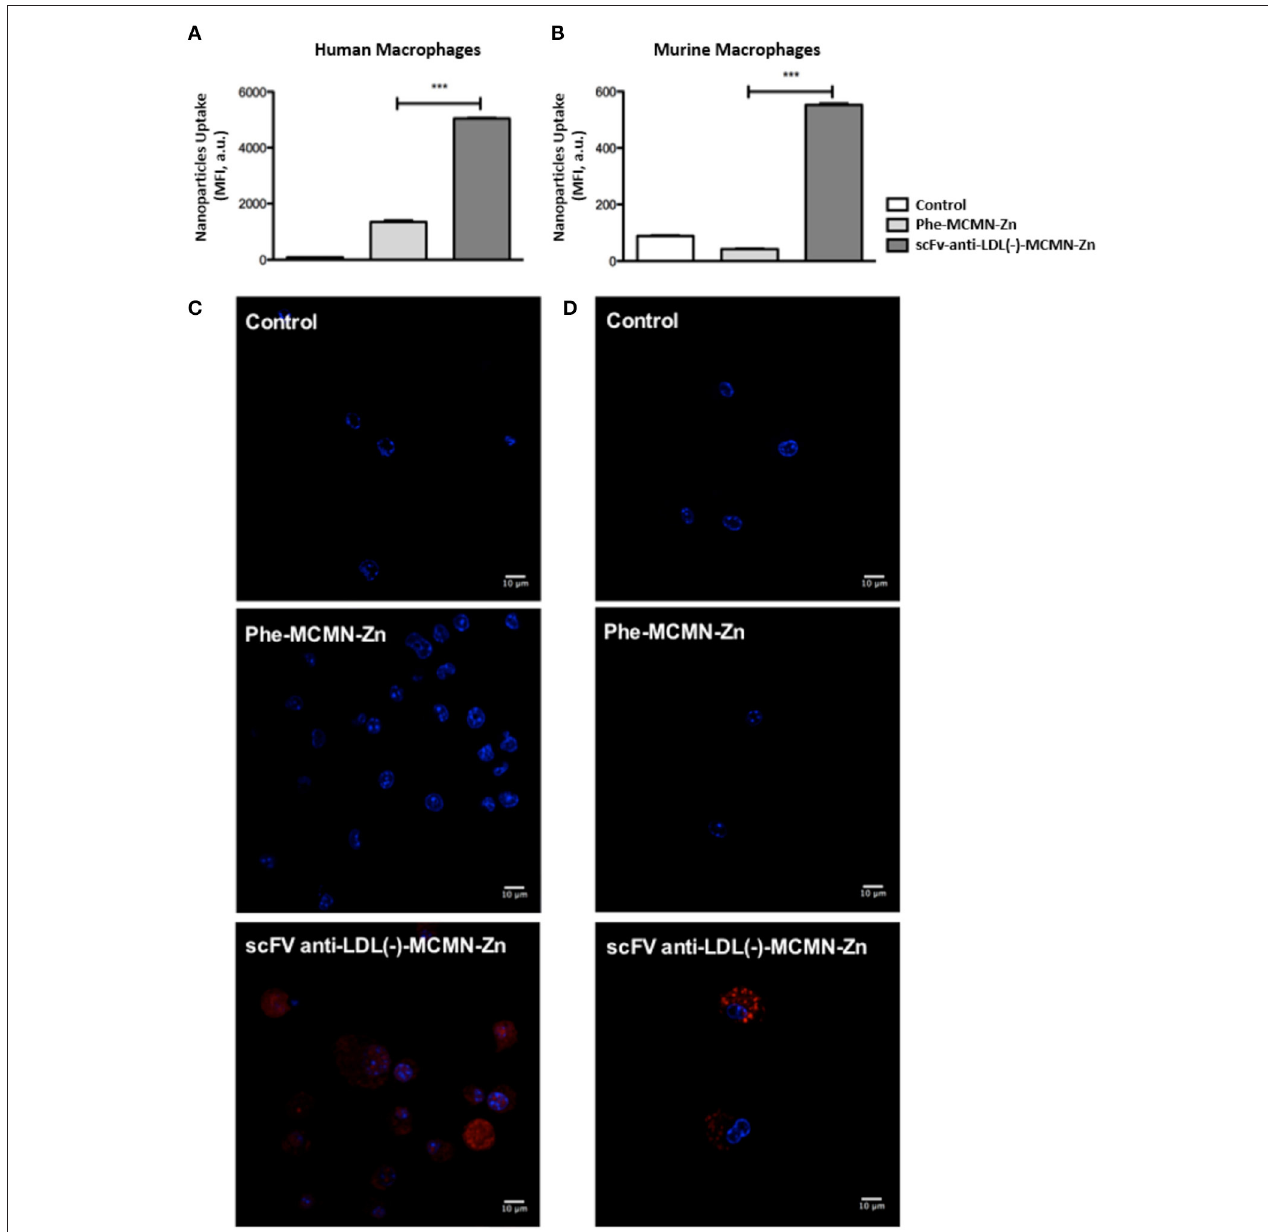
FIGURE 1 | Internalization of the scFv-anti-LDL(-)-MCMN-Zn nanoformulation by human and murine primary macrophages. (A,B) Flow cytometry measurements data from human (A) and murine (B) primary macrophages treated with 10 4 particles/mL of scFv-anti-LDL(-)-MCMN-Zn nanoformulation (containing 6.25 µ g/mL of scFv) for 3h. (C,D) Representative confocal microscopy images of human (C) and murine (D) macrophages exposed to the same conditions. Nanocapsules were labeled with Rhodamine B (red fluorescence) and macrophages nuclei stained with DAPI (blue fluorescence) (63 × magnification, scale bar = 10 µ m). Data from three independent experiments, performed in triplicate, are expressed as the means ± SD; *** p < 0.001 compared with Control; ANOVA followed by the Tukey-Kramer’s test.